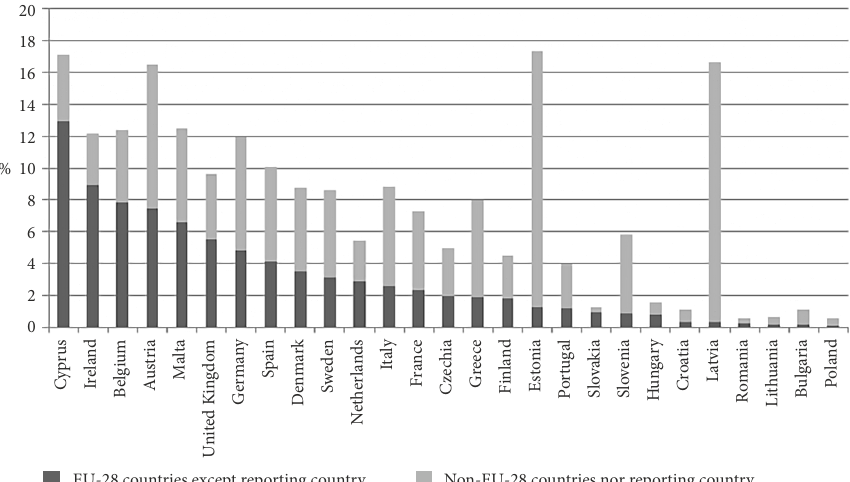
Figure 2. Share of immigrants (EU, Non-EU) in total population in EU countries, 2017 (source: computation based on Eurostat Statistics,